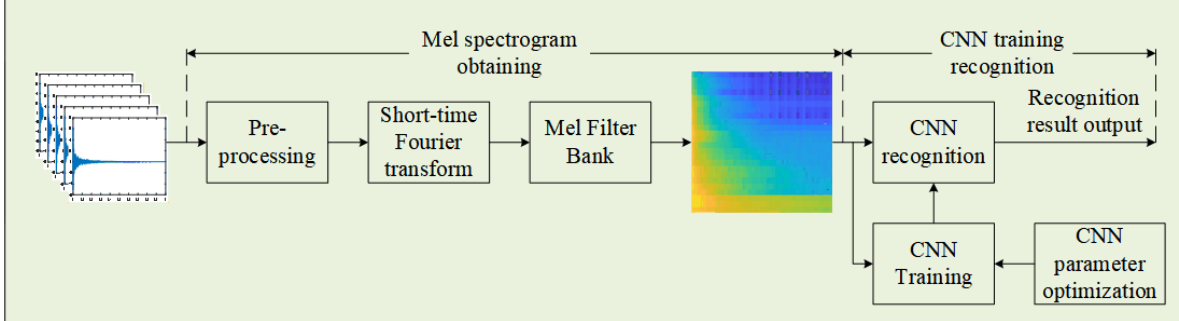
Figure 1. Schematic diagram of the working principles.